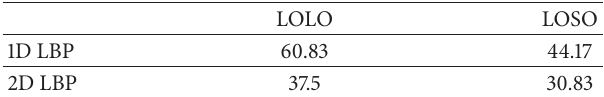
Table 9: The performance of classifiers for VSFL model when the 1D LBP scheme is used for feature extraction.